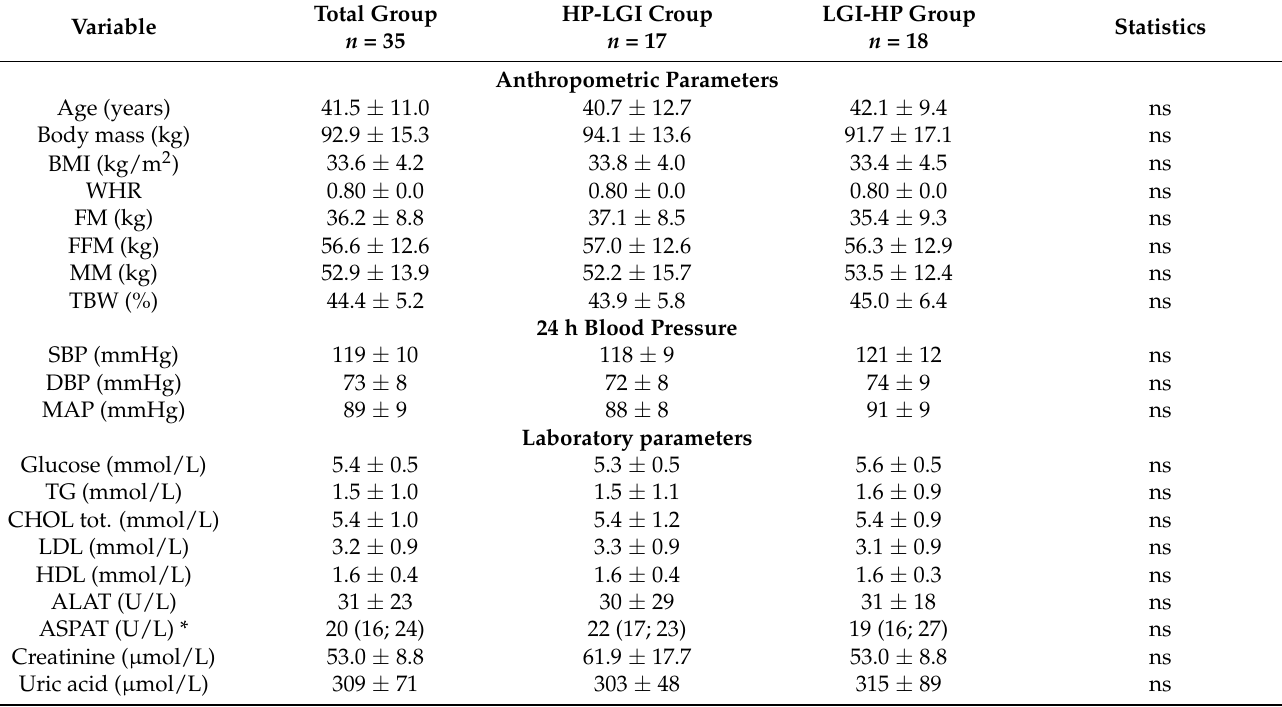
Table 1. The baseline characteristics of the investigated subjects.